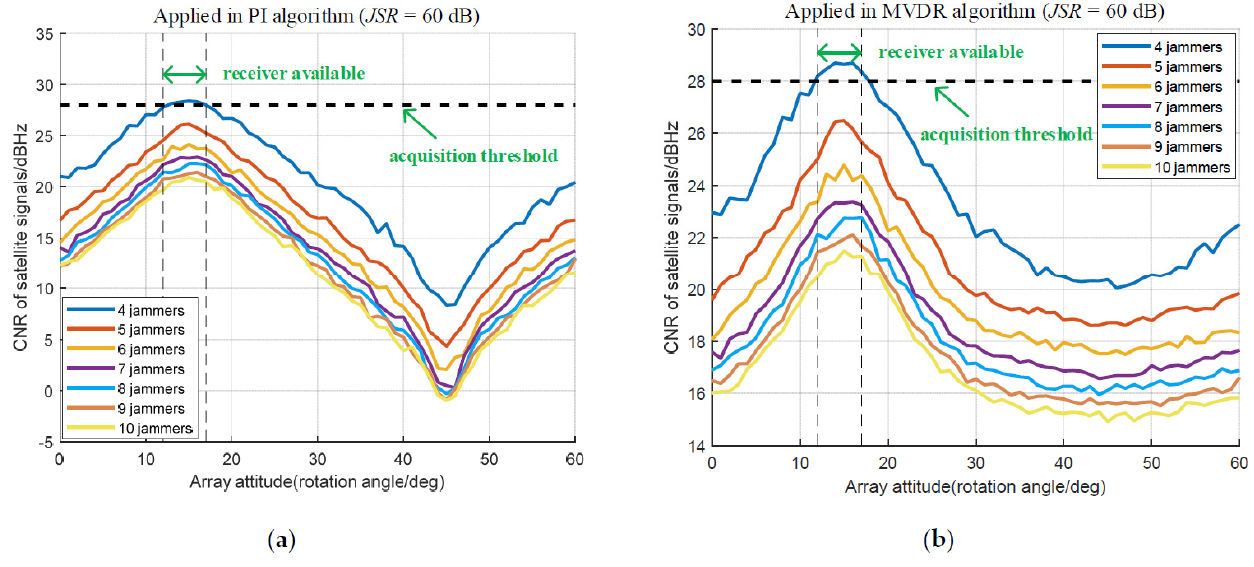
Figure 9. Navigation signal CNR of anti-jamming output. ( a ) Applied in PI algorithm. ( b ) Applied in MVDR algorithm.